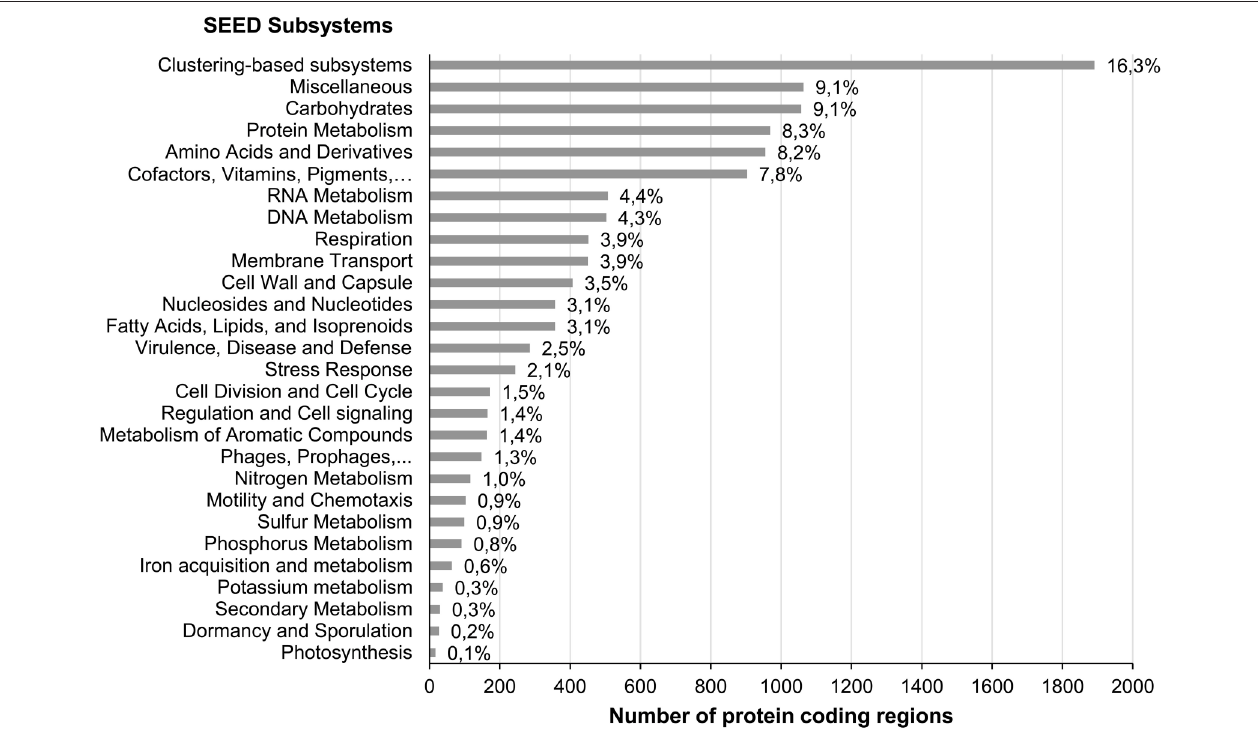
FIGURE 3 | Functional classification of contigs using MG-RAST. Of 17,994 protein coding regions predicted from contigs by MG-RAST, 65% (11,636) were assigned by MG-RAST to SEED functional categories (Subsystems).